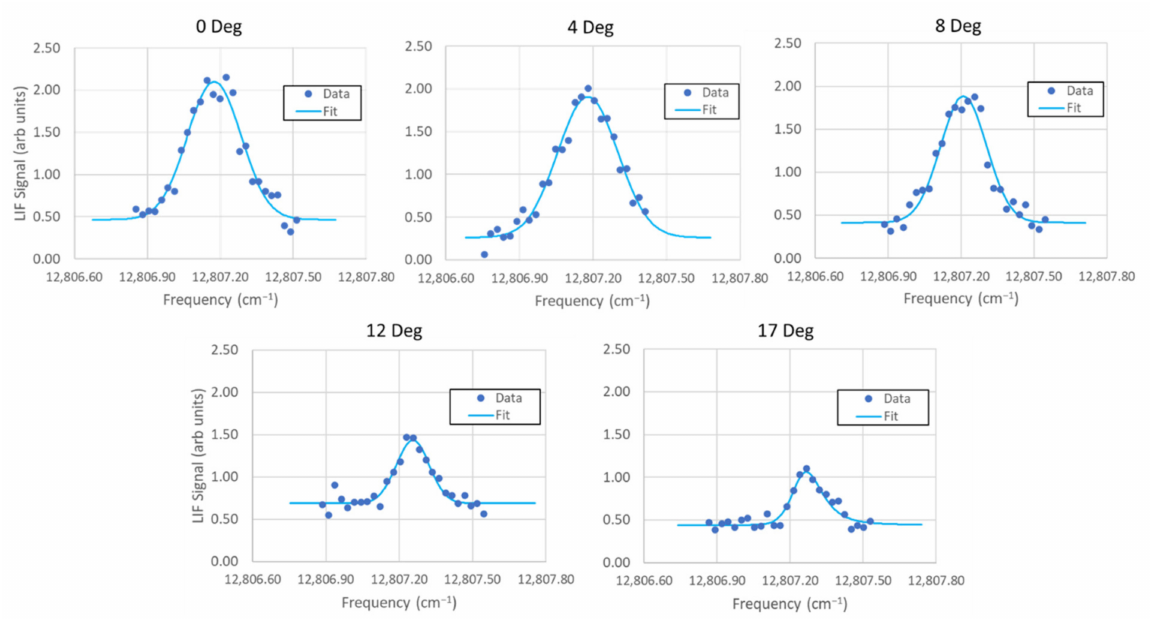
Figure 9. Molybdenum Doppler profiles at the five grid angles probed by LIF for DTL28-H-H. Progressive peak shifting occurs from grid center to edge, together with narrowing of the profile. Profiles are pure Gaussian at grid center and acquire significant Thompson character near the edge.